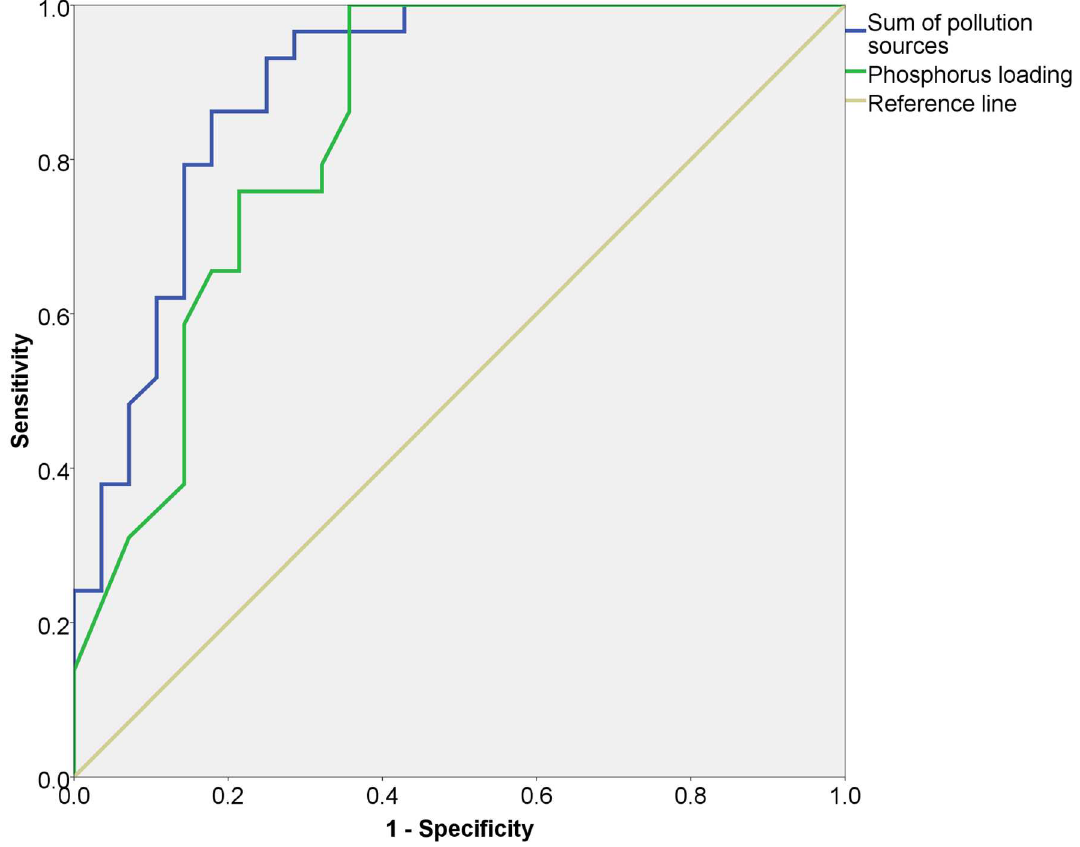
Fig 4. Receiver Operating Characteristic curve for the phosphate concentration eutrophication threshold of 0.1 mg L -1 for sub-basins against microscale observations of the sum of pollution sources and macroscale data related to phosphorus loading. The x-axis is denominatedas 1 minus Specificity or the false positive